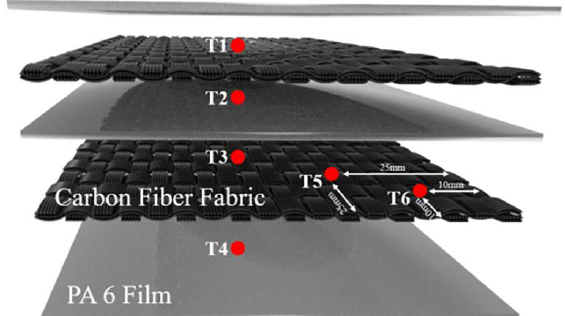
Figure 3. Schematic of locations of embedded thermocouples in a stack CF/PA 6 composites laminate under SRE heating.